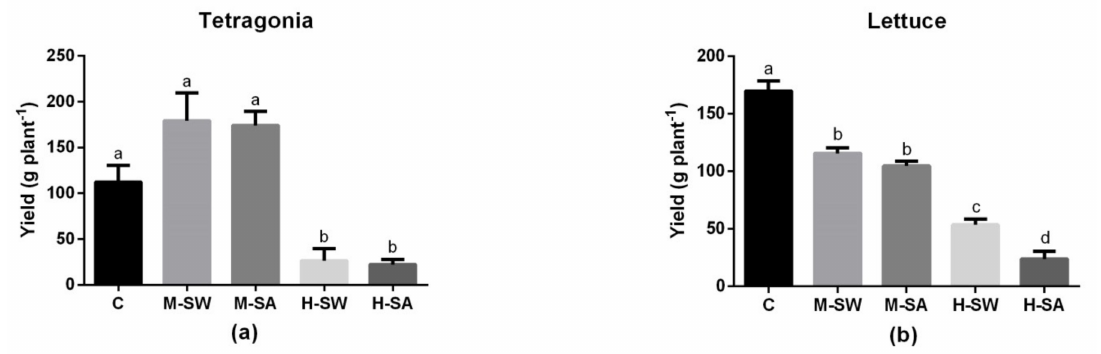
Figure 2. The Tetragonia ( a ) and lettuce ( b ) plants’ yield. Values are single plants’ shoot weight means ( n = 4) ± SEM expressed in grams. Different letters indicate significant differences assessed at p < 0.05 (Tukey’s test).